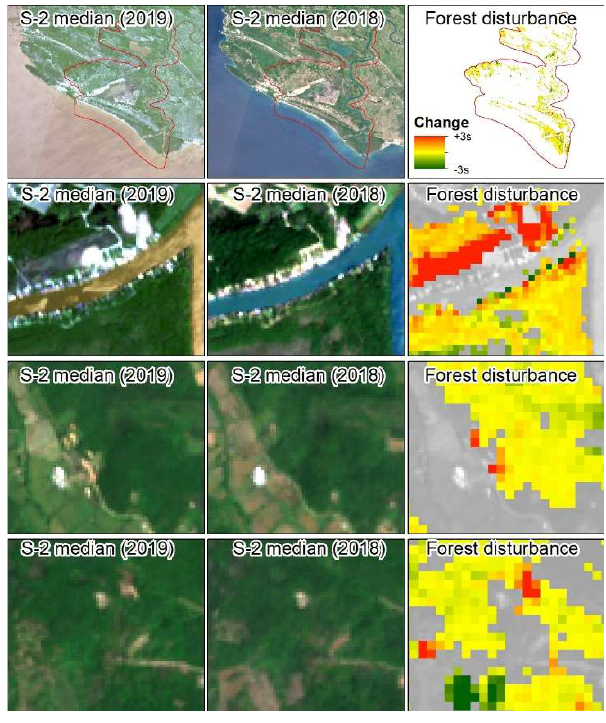
Figure 4. Deforestation detection among the 2019-2018 annual composites. Apart from forest removal (red color), the approach can also flag pixels experiencing afforestation (green pixels)